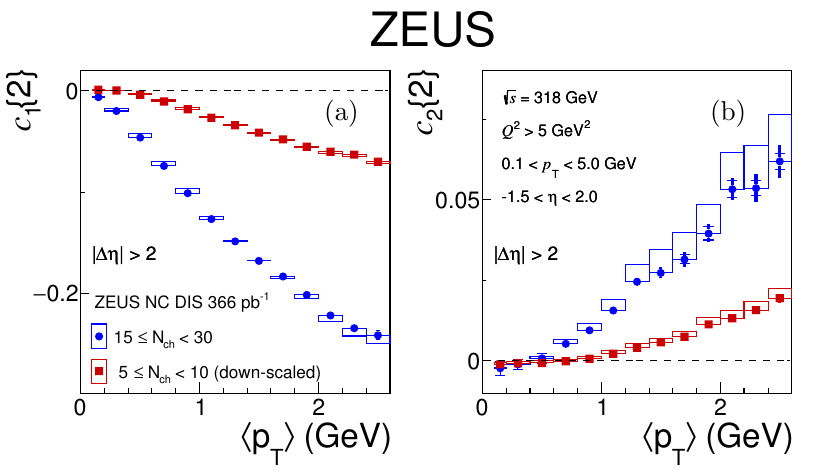
Figure 9 . Correlations c 1 f 2 g and c 2 f 2 g as a function of h p T i for (a) low and (b) high N ch . Low N ch correlations are down-scaled by a factor of h N ch i details are as in (cid:12)gure 7.